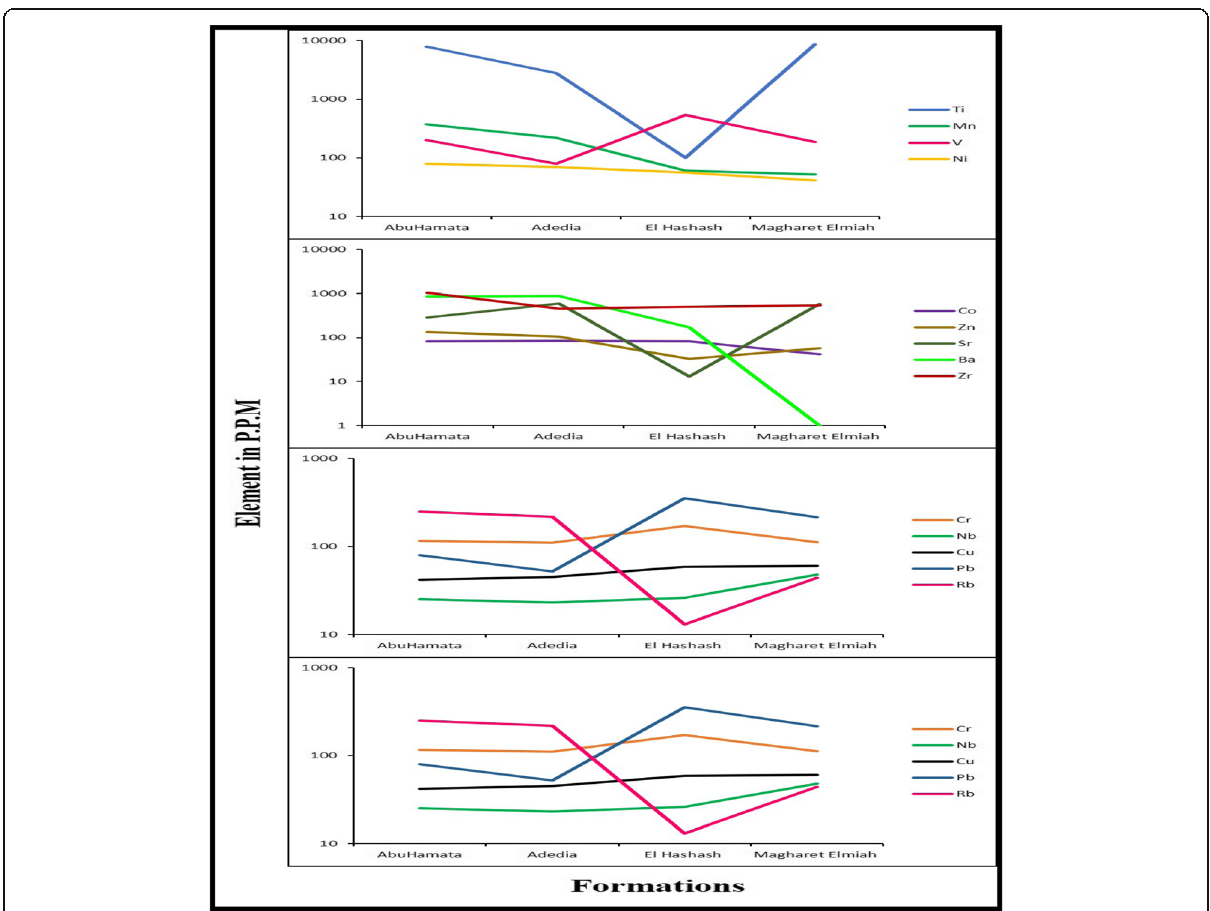
Fig. 10 Distribution curves of chemical components (trace elements ppm of Paleozoic mudrocks